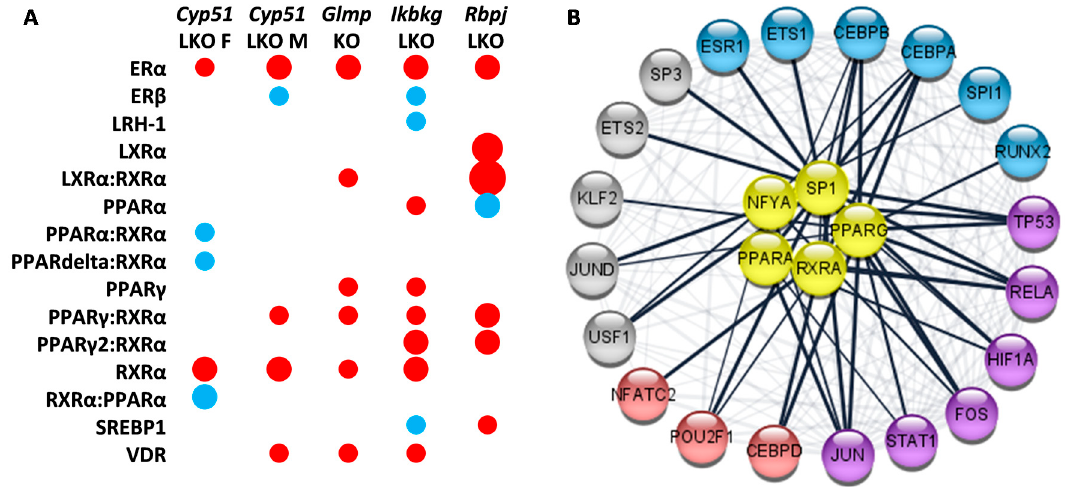
Figure 4. Selected enriched transcription factors (TFs) in mouse genetic models of liver fibrosis. ( A ). Model-specific enrichment of nuclear receptors in fibrotic models. Red indicates positive enrichment and blue negative. The size of the bubble reflects the fold change of each pathway. ( B ). Common enriched transcription factors reveal network-like interactions between regulators of lipid metabolism (yellow) and TFs involved in regulation of cancer pathways (blue and violet) and the immune system (red and violet).